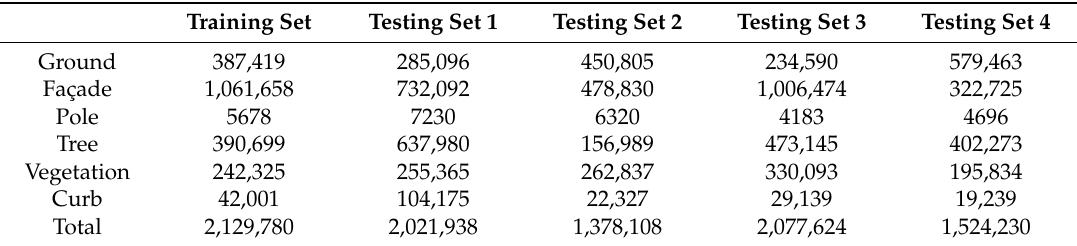
Table 2. Number of 3D points in six different classes of training and testing sets.